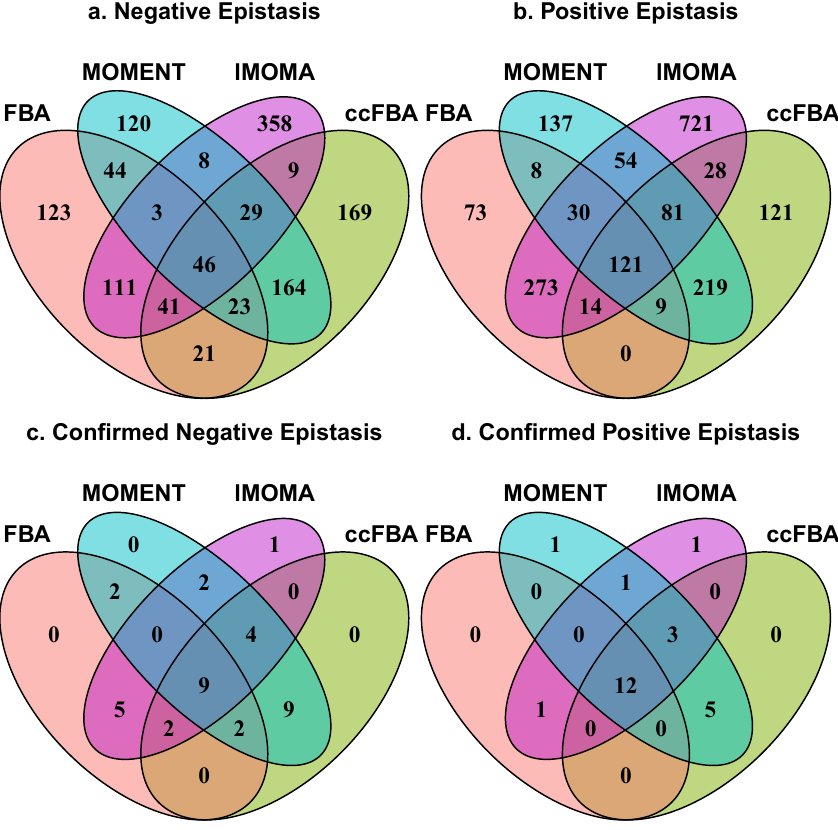
Figure 2. Venn diagrams showing the overlap of negative ( a , c ) and positive ( b , d ) epistasis predictions by the four methods. Panels (a) and (b) show total predictions. Panels (c) and (d) show only those predictions confirmed by the high-confidence set of experimental epistasis